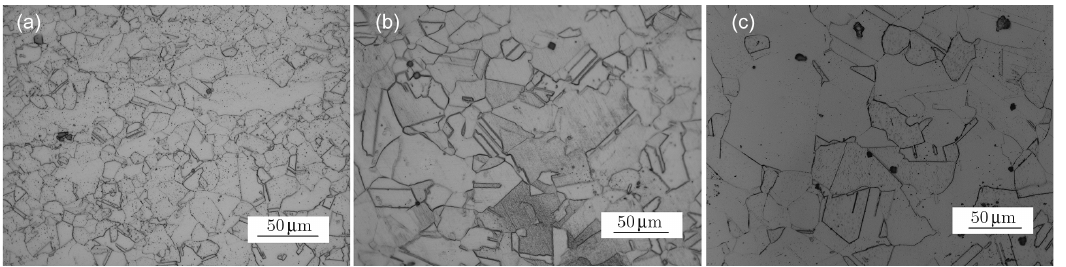
Figure 4: Microstructures of samples deformed at different temperatures when strain rate was 0.01 s – 1 : (a) 1,000°C; (b) 1,050°C; and (c) 1,100°C.